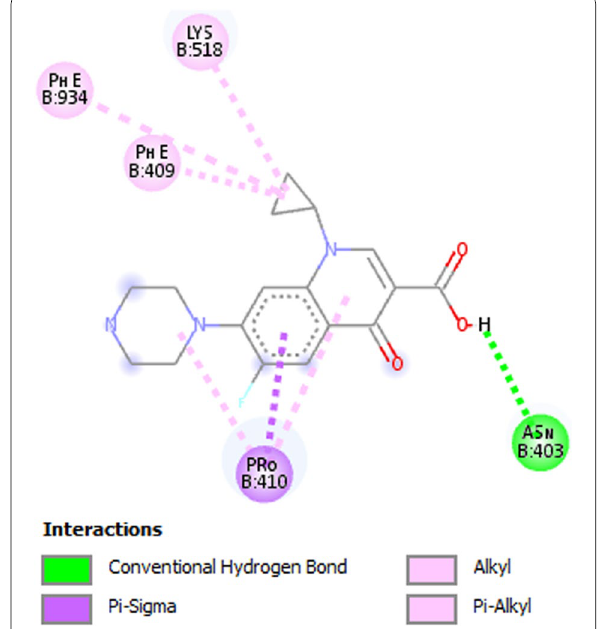
Fig. 12 2D interaction of ciprofloxacin with crystal structure of S . aureus (PDB: 3HO8)